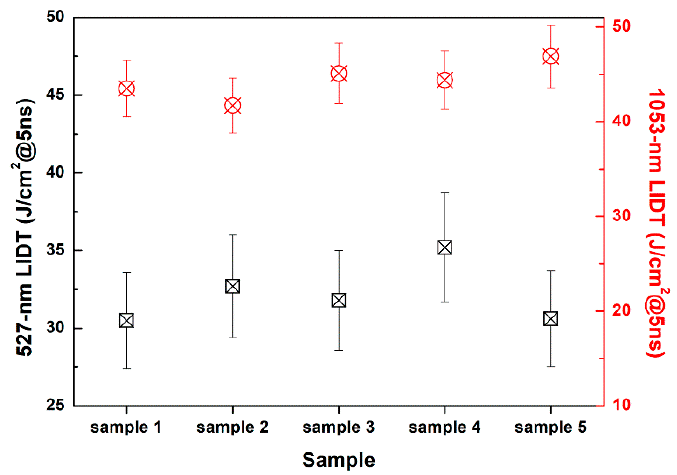
Figure 7. Laser-induced damage threshold (LIDT) results of studied coating system at 527 nm and 1053 nm for five individual samples.